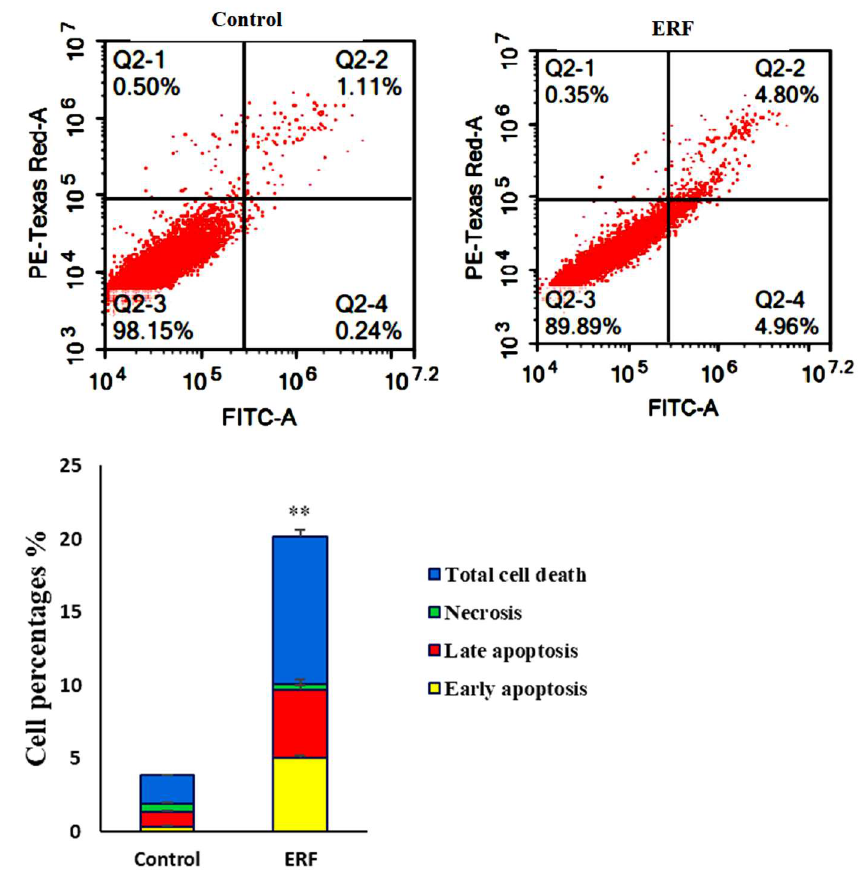
Figure 9. In contrast to untreated cells, apoptosis and necrosis were detected utilizing Annexin V-FITC and PI dual staining after 24 h of treating HepG2 cells with IC 50 of the study crude extract RF. ** Significantly different from the control group; data are presented as mean ± SD; n = 3.